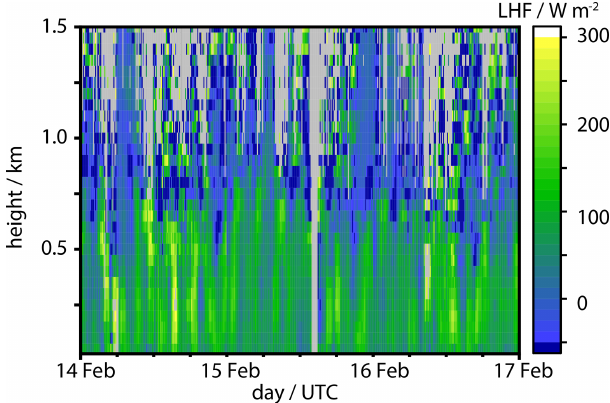
Figure 6. Vertical latent-heat (vaporization enthalpy) flux as a func- tion of time and height above the platform as measured from the combination of water vapor Raman lidar (ARTHUS) and Doppler wind lidar aboard the R/V MS-Merian . The mean value over the 3d period is 100Wm − 2 at 200m, and the fluxes are positive through- out the sub-cloud